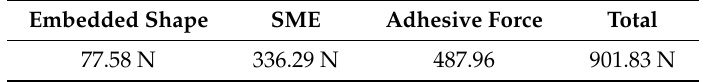
Figure 13. Hybrid SMA wire.